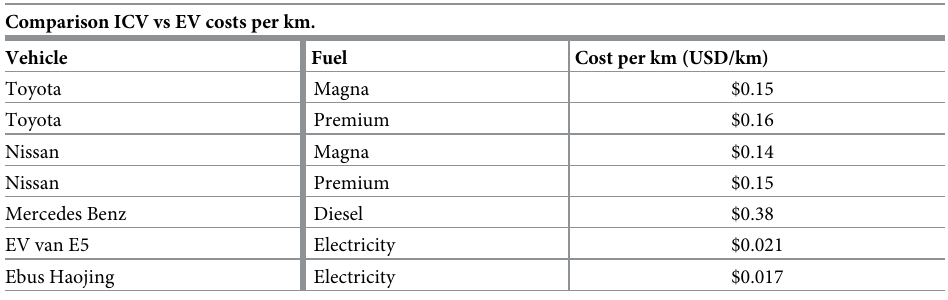
Table 13. Cost per km ICV vs electric alternative proposed.